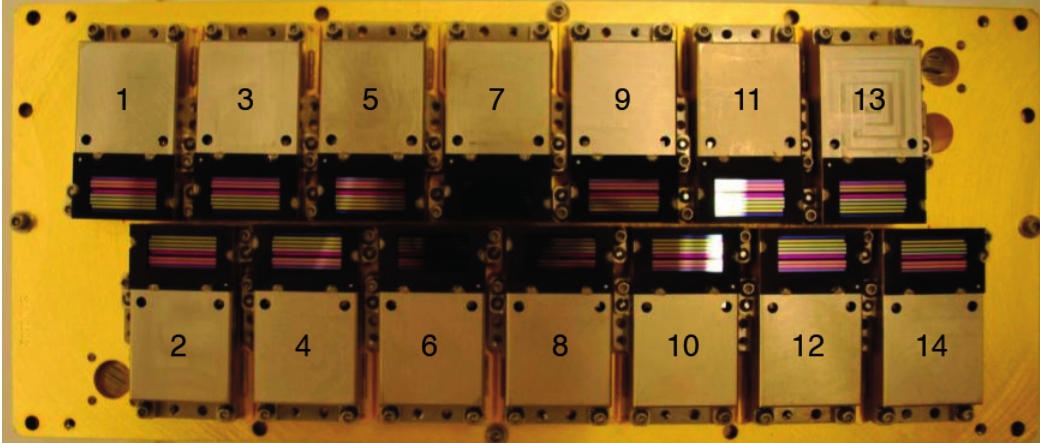
Figure 1. A photograph of the completed OLI focal plane assembly, with the FPM numbers added. The optical axis runs through the center of the modules, between the odd number FPMs and the even number FPMs. The colored bars are the filter sticks for each band on each module. The detectors are behind the filter sticks. The band order of the filters from most off-axis to least off-axis is: Cirrus, SWIR1, SWIR2, Green, Red, NIR, CA, Blue, Pan, such that on the assembled focal plane the Pan band arrays are closest together in the odd/even FPM pairs, and the Cirrus bands are furthest